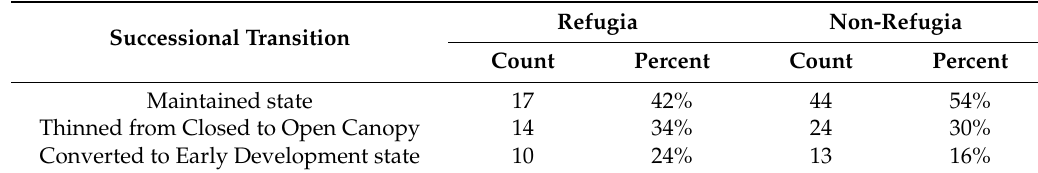
Table 7. Primary plot structural transitions by pre-fire refugia